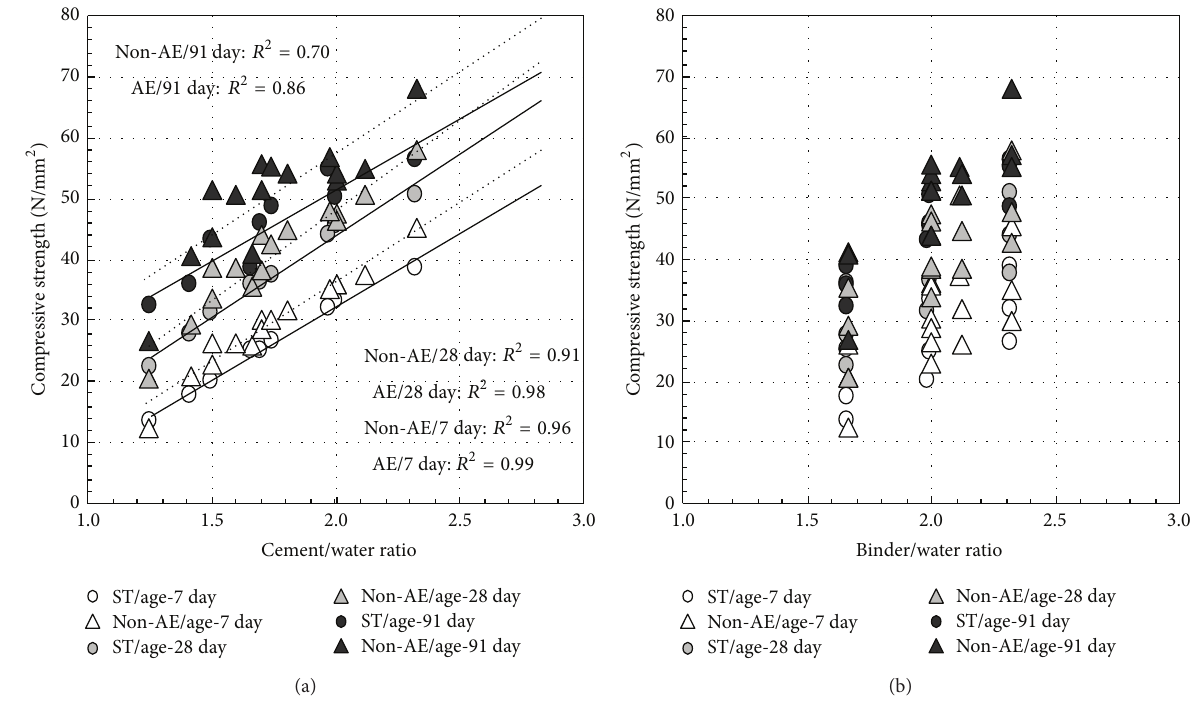
Figure 2: Relationship among cement-water ratio, binder-water ratio, and compressive strength.